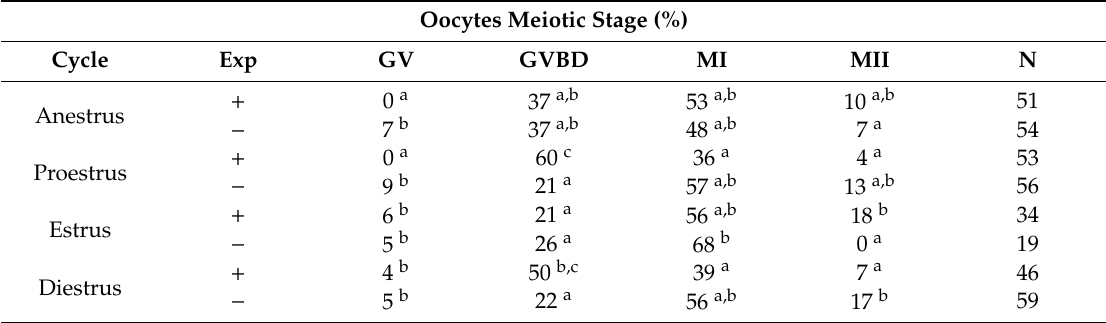
Table 2. In vitro canine meiotic development according to the expansion of cumulus cells and the estrous cycle. Oocytes Meiotic Stage